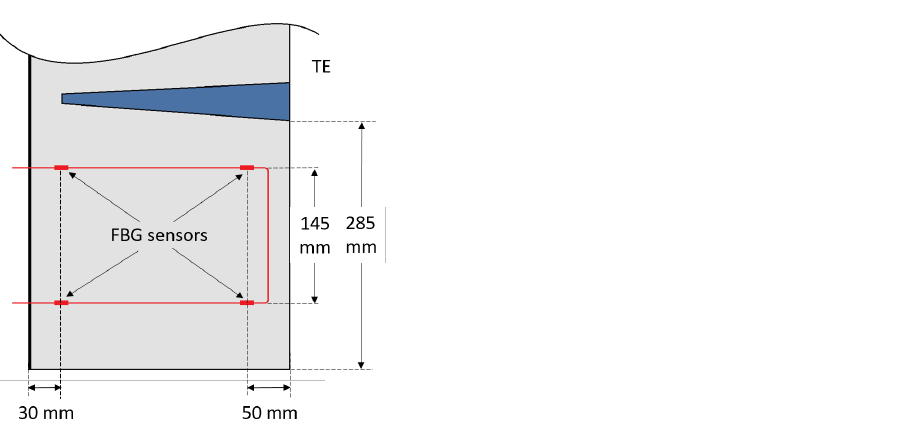
Figure 6. Location of the fibre (in red) and the FBG sensors on one of the morphing modules. When the fibres, and in turn the gratings, are subjected to external mechanical (or thermal) perturbations, two optical changes are introduced that are vital for capturing the shape of the wing. The output of the first change gives the local strain measurement at the location of the grating measured by a spectral sensing interrogator. The